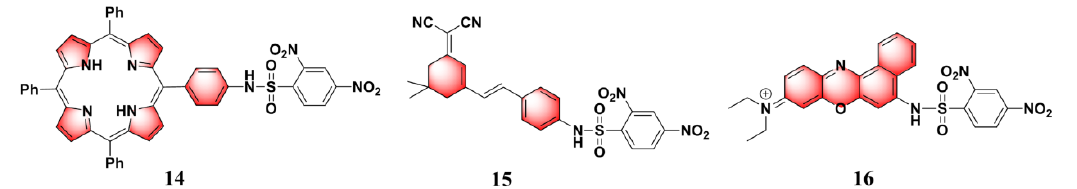
Figure 6. ( a ) Structure and reaction of probe 13 with PhSH. ( b ) Bright-field images of HeLa cells after being treated with probe 13 . ( d ) HeLa cells preincubated with thiophenol and then incubated with probe 13 . ( c , e ) Fluorescence images of ( b , d ), respectively. Reproduced with permission from Reference [76]; copyright American Chemical Society.